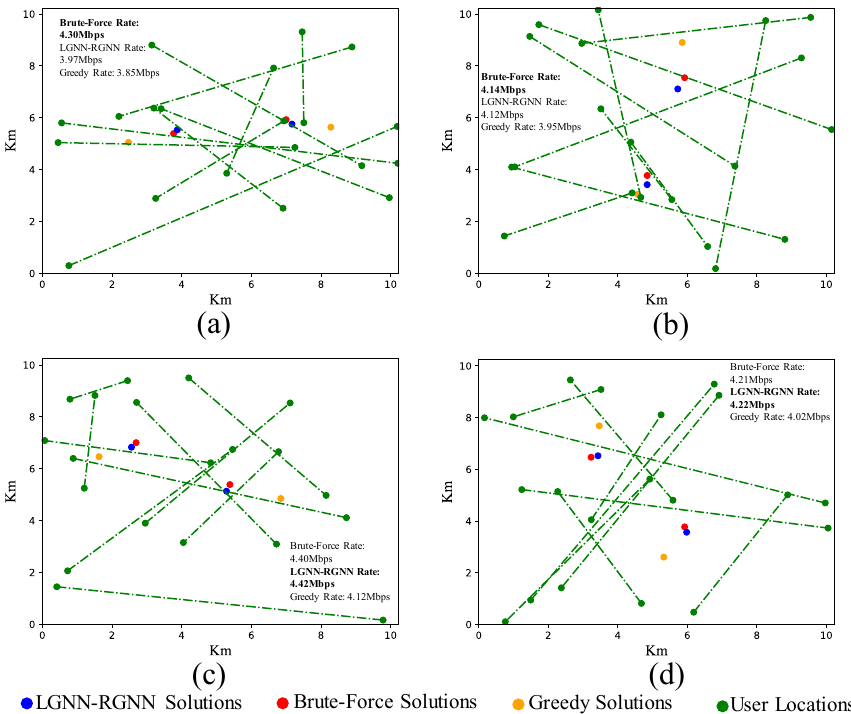
Figure 7. Results comparison among LGNN-RGNN, Brute-force, and greedy algorithm, with |V s | = 10, |V u | = 2 using different algorithms. ( a ) Performance of Brute-Force is 4.30 Mbps, and performance of LGNN-RGNN is 3.97 Mbps, ( b ) Performance of Brute-Force is 4.14 Mbps, and perfor- mance of LGNN-RGNN is 4.12 Mbps, ( c ) Performance of Brute-Force is 4.40 Mbps, and performance of LGNN-RGNN is 4.42 Mbps, ( d ) Performance of Brute-Force is 4.21 Mbps, and performance of LGNN-RGNN is 4.22